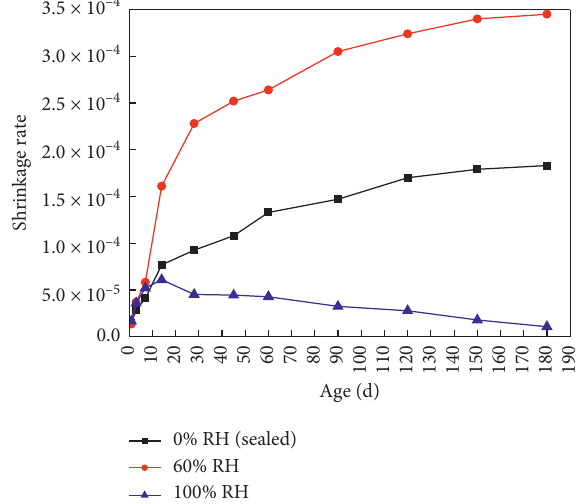
Figure 8: Effects of varying ambient humidities on the CFA’s shrinkage